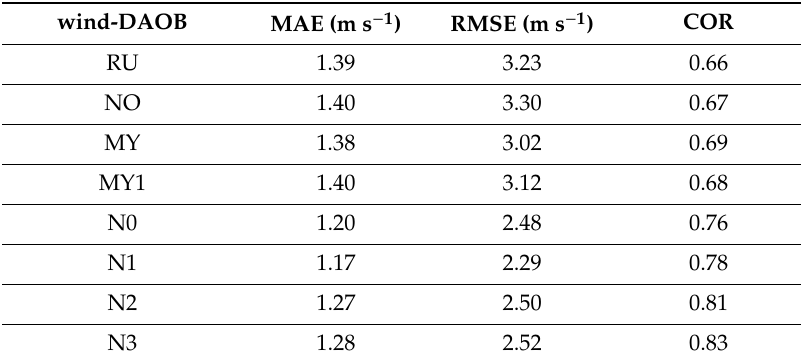
Table A7. Mean absolute error (MAE), root mean square error (RMSE), and correlation coe ffi cient (COR) for surface wind at Tiaret (Algeria); meteorological aviation reporting (METAR)station code = DAOB.